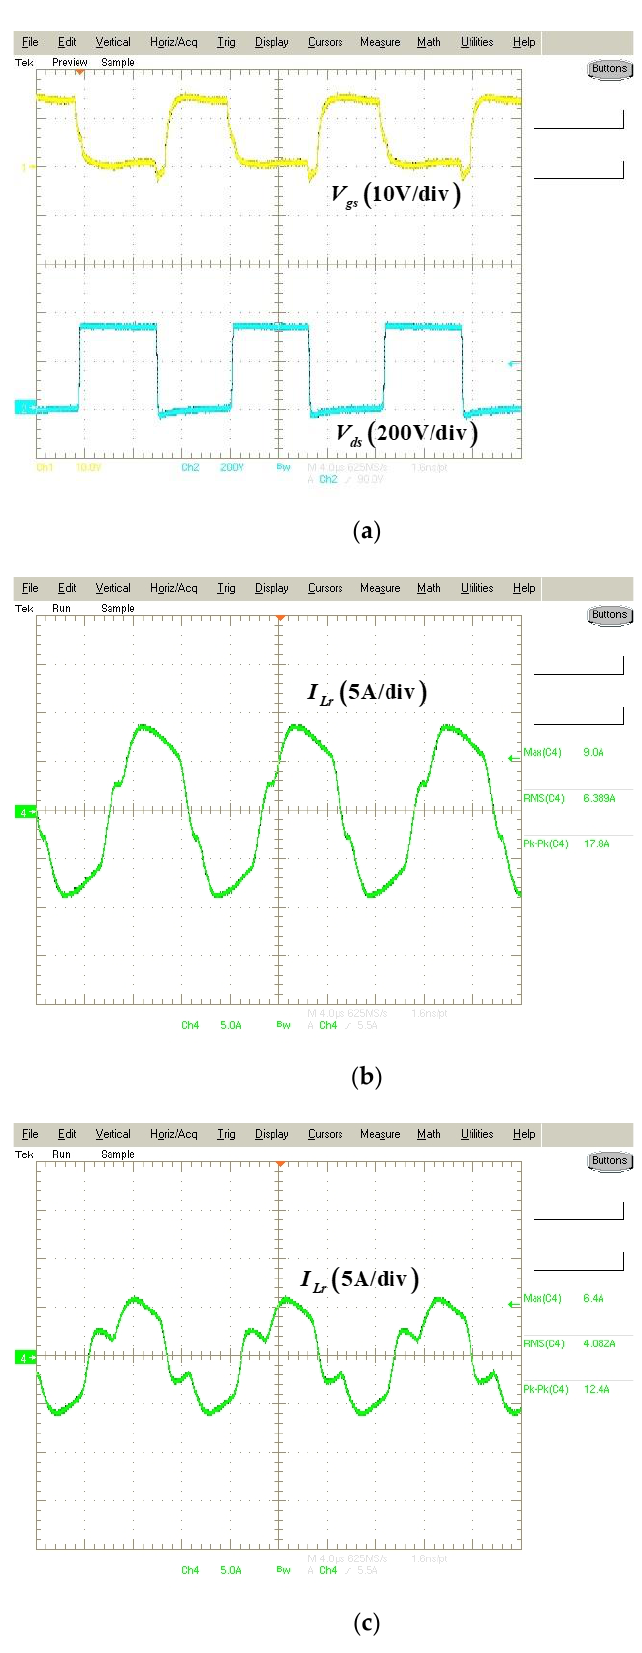
Figure 9. Experimental test waveforms; ( a ) gate input voltage V gs and switching drain–source voltage V ds ; ( b ) resonant inductor current I Lr at full-load condition; ( c ) resonant inductor current I Lr at half-load condition.